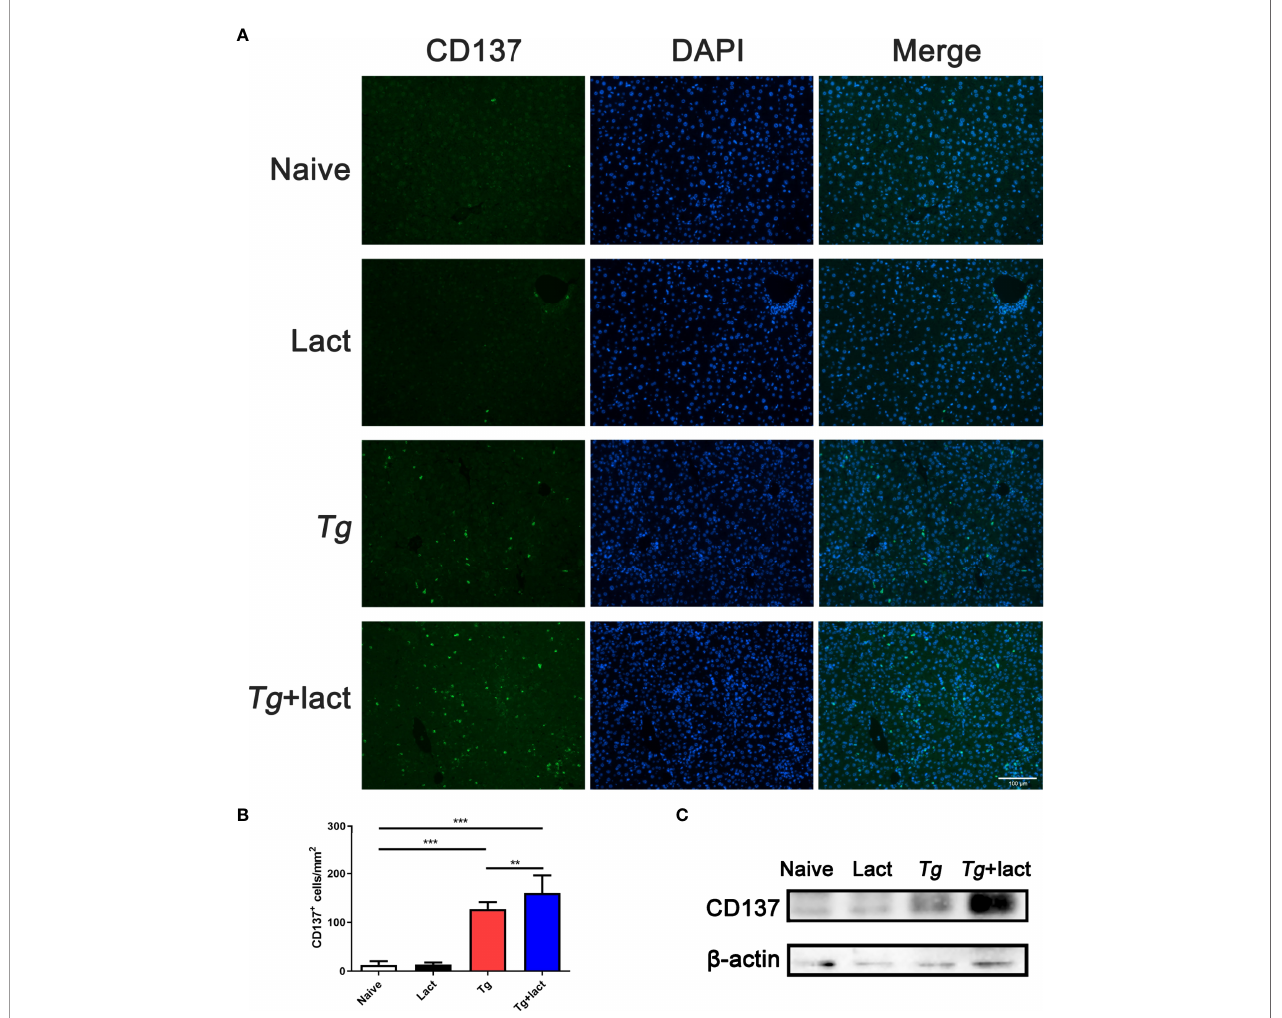
FIGURE 5 | CD137 + cells in the liver tissues of mice from different groups. (A) Immuno fl uorescence staining showed CD137 + cells (labeled green) in the livers of mice. Original magni fi cation 200× (scale bar = 100 µm). (B) Morphometric analysis in liver tissues by showing the number of CD137 + cells per square millimeter. Data are presented as means ± SD; experiments were performed with four mice per group. ** P < 0.01, and *** P < 0.001. (C) The protein levels of CD137 in the livers of mice were detected by Western blot